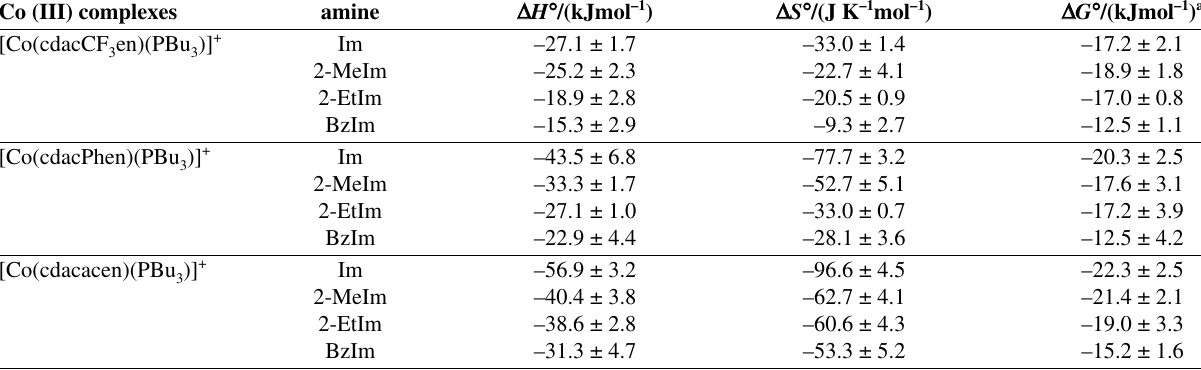
Table 4. The experimental Thermodynamic parameter values, Δ H ° , Δ S ° and Δ G ° for Co(III) Schiff base complexes with various cyclic amines in CH CN. 3 Co (III) complexes